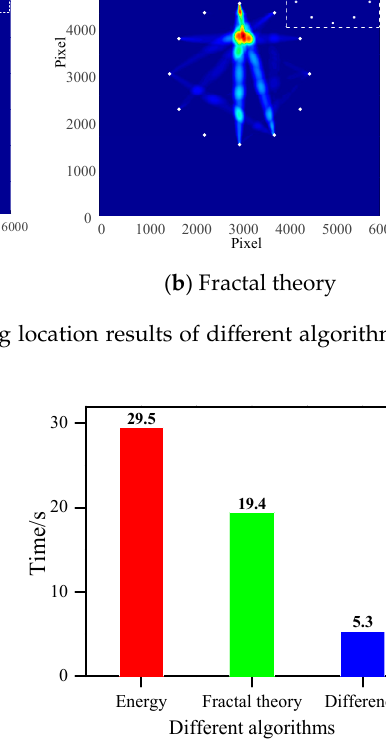
Figure 12. Time required to calculate damage factor by different algorithms.